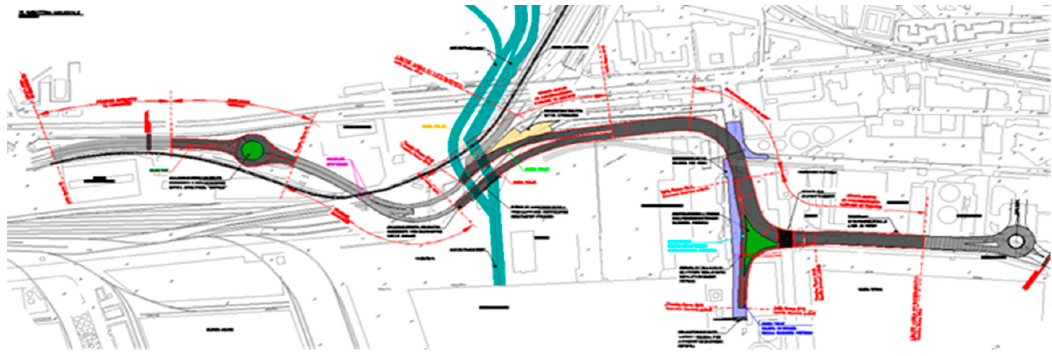
Figure 3. Plan view of the design project.